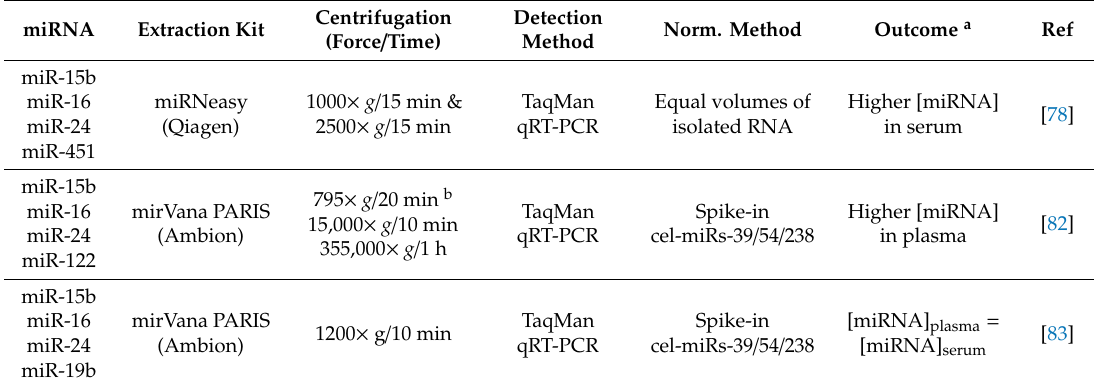
Table 3. Comparison of miRNAs expression levels in plasma and serum samples obtained from healthy individuals by three independent